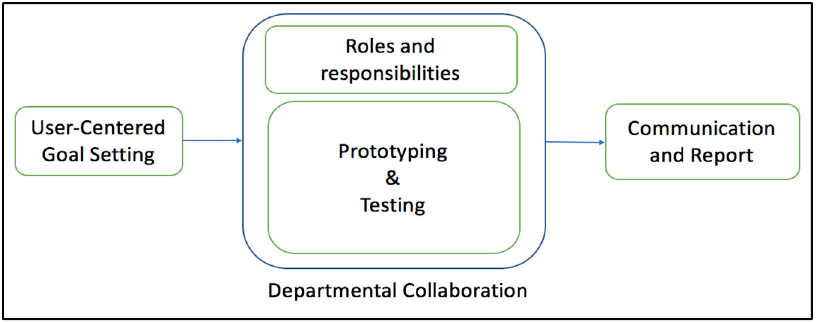
Figure 4. Corporate design thinking